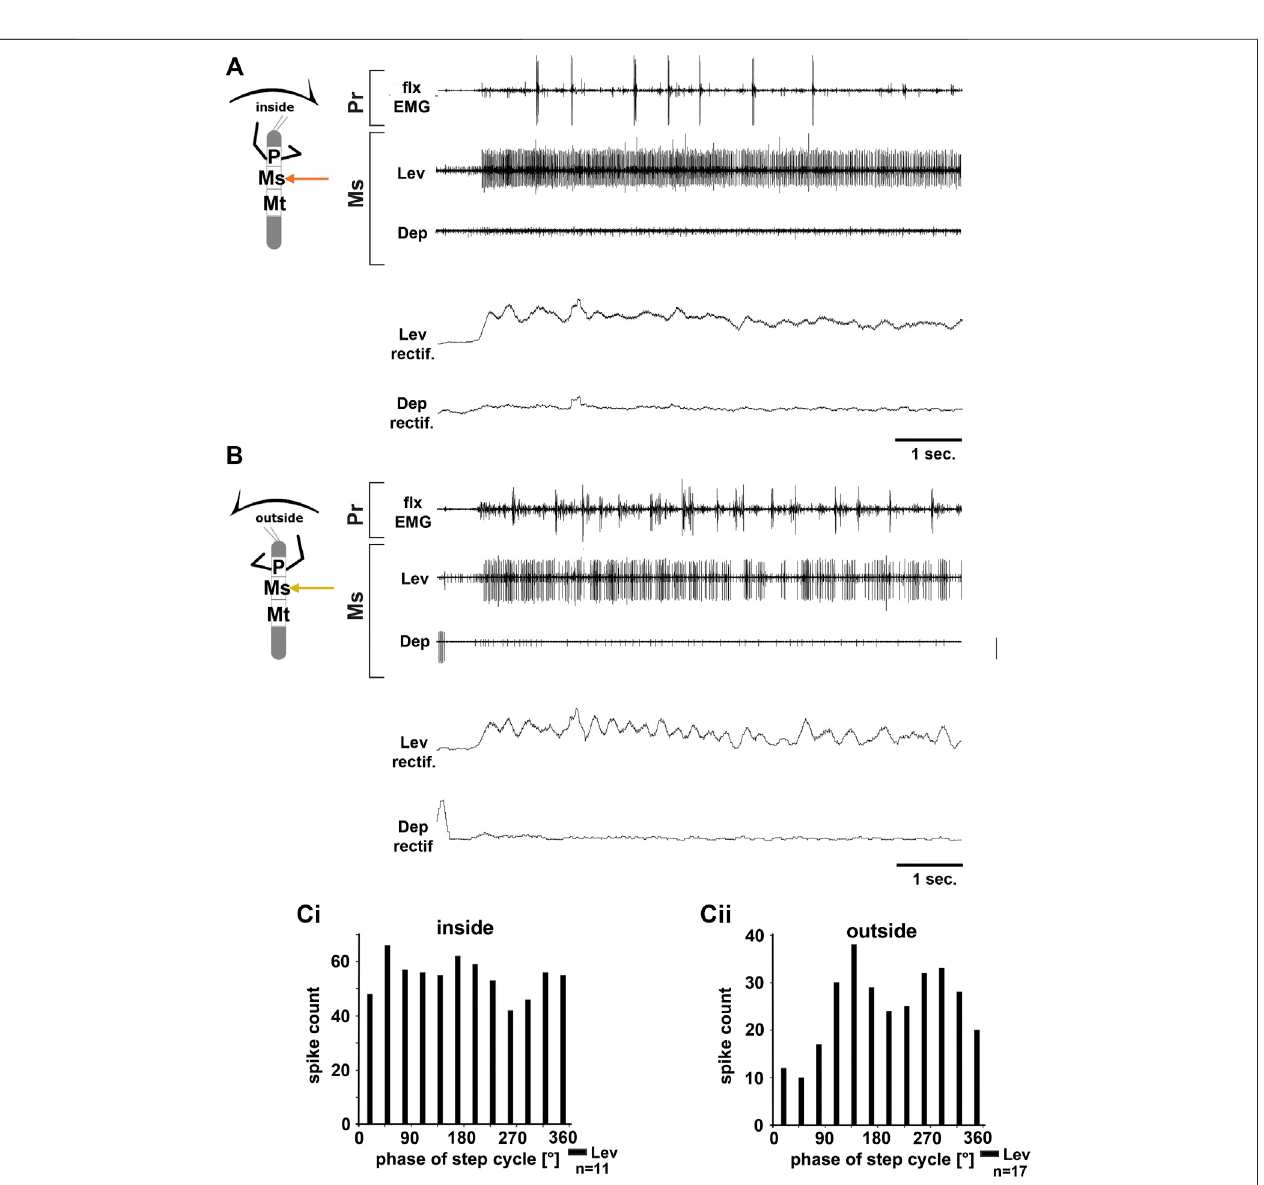
FIGURE 3 | Motor output of the mesothoracic levator and depressor trochanteris MN pools in the deafferented ganglion during front leg (FL) inside (A,Ci) and outside (B,Cii) stepping from the sameanimal. (A) FL fl exor EMG recording (top),together with extracellular recordings of the ipsilateral levator (C1 nerve, second trace) and depressor (C2 nerve, third trace) nerve during an inside stepping sequence, and the respective recti fi ed activities (fourth and fi fth trace); (B) FL fl exor EMG (top), together with extracellular recordings of the ipsilateral levator (second trace) and depressor (third trace) nerve during an outside stepping sequence, and the respective recti fi ed activities (fourth and fi fth trace); (Ci) Phase histogram of levator and depressor nerve activity from the experiment in (A) with respect to the FL step cycle during inside stepping; (Cii) Phase histogram of levator and depressor nerve activity from the experiment in (B) with respect to the ipsilateral FL step cycle during outside stepping. n = number of analyzed steps. Pr, Ms: Pro- and Mesothoracic location of the recording, respectively; Lev, Dep: levator trochanteris and depressor trochanteris motor neuron activity from nerves C1 and C2, respectively. The sketch indicates a stick insect with front legs in a fl exed (inside) or stretched (outside) position, and the arrow above indicating the turning direction, the arrow on the side the recorded thoracic segment.